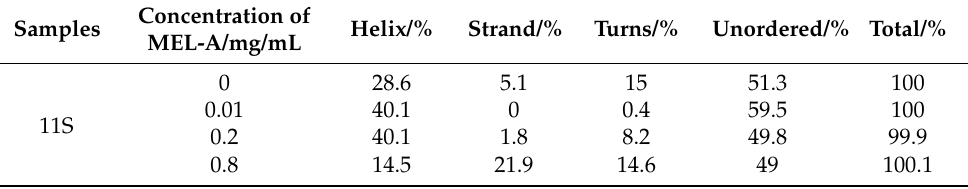
Table 2. Prediction values of protein secondary structure upon different MEL-A concentrations.